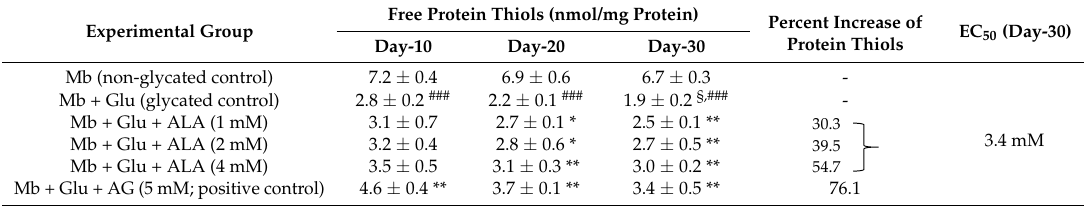
Table 4. Effect of α -lipoic acid on protein thiols oxidation in glucose-induced myoglobin glycation. Free Protein Thiols (nmol/mg Protein) Experimental Group